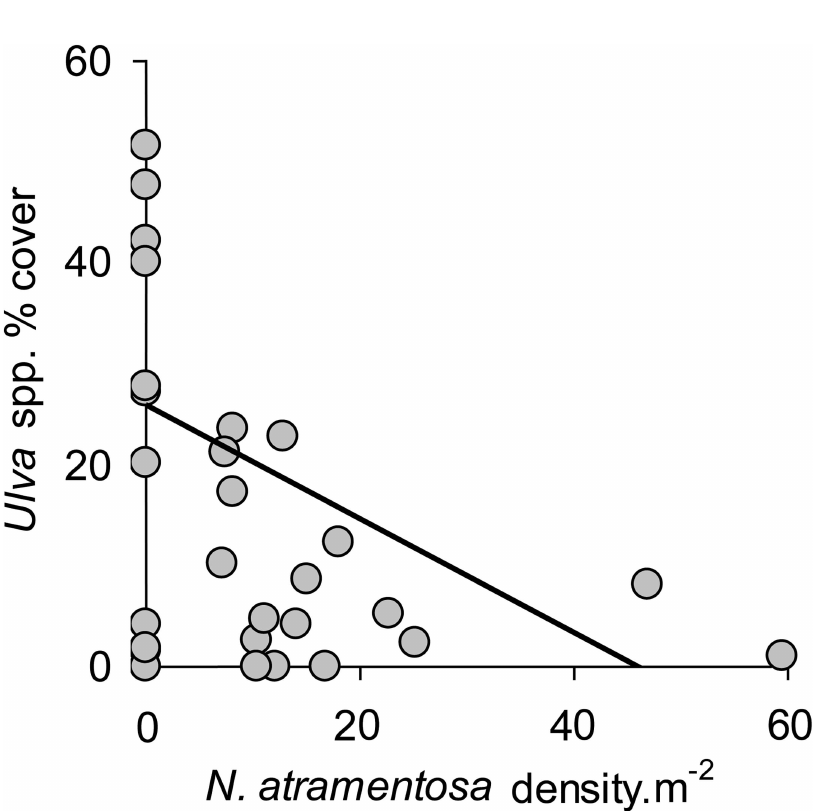
Fig 6. Density of the grazer Nerita atramentosa is positively correlatedwith Ulva algae cover. Correlation betweendensity of the grazer N . atramentosa and cover of Ulva (arcsine transformed; [49]) on boulderswhich had serpulimorphtubes. Linearregressionwas used to visuallyrepresent the result from the permutational ANCOVA. Data were pooledfrom three random sites; n =